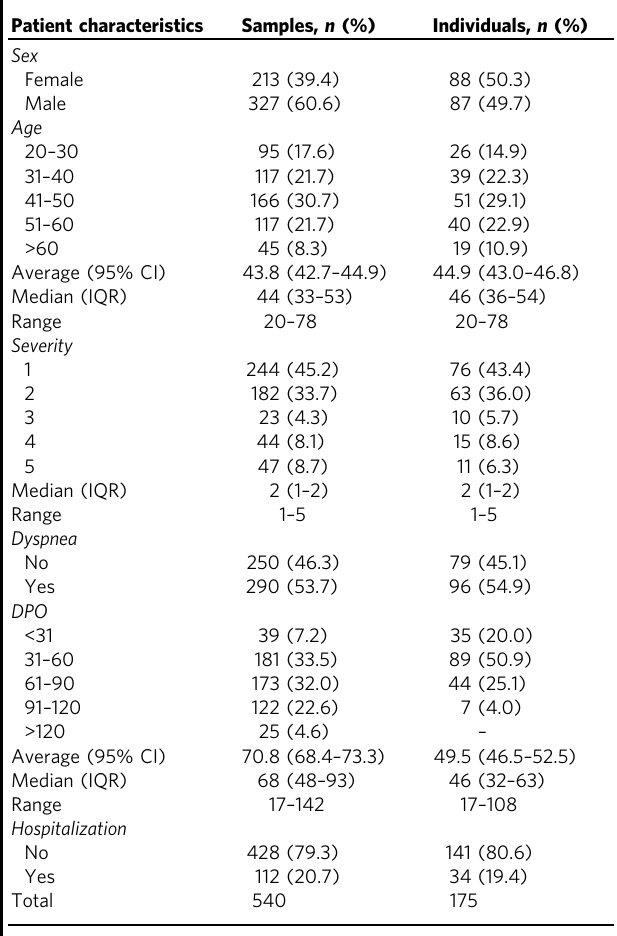
Table 1 Demographics and characteristics of the plasma donor